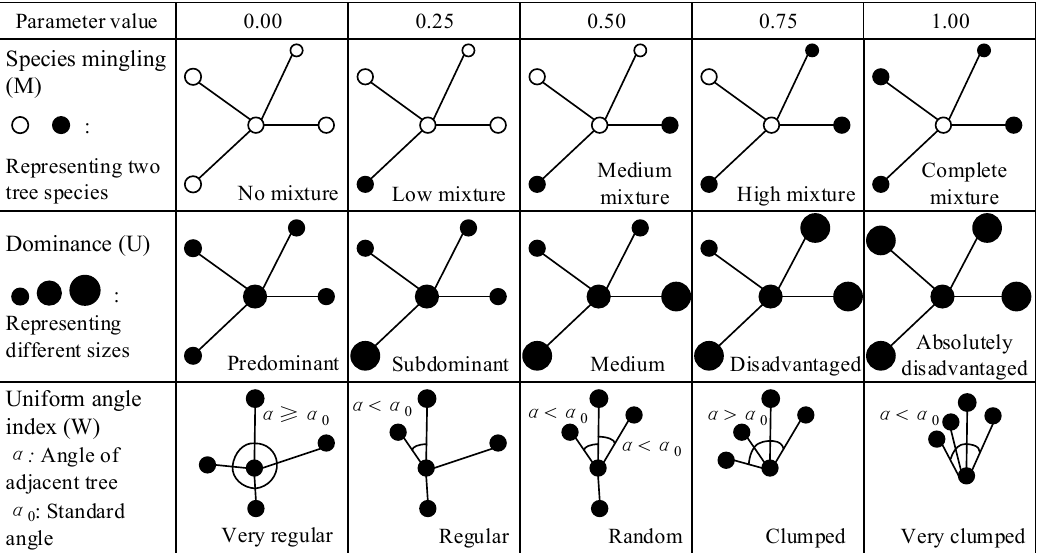
Figure 11. Definition of the spatial structure parameters of mingling, dominance, and the uniform angle index.